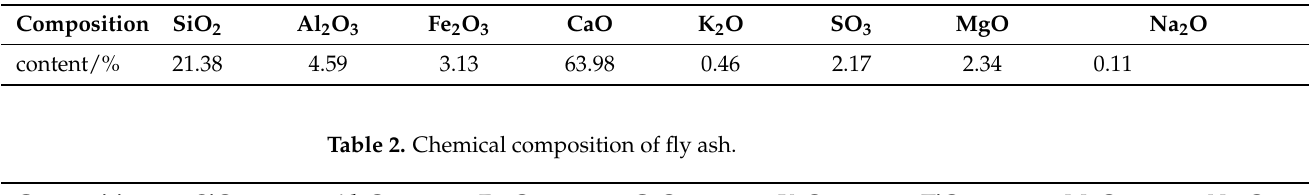
Table 1. Chemical composition of cement.